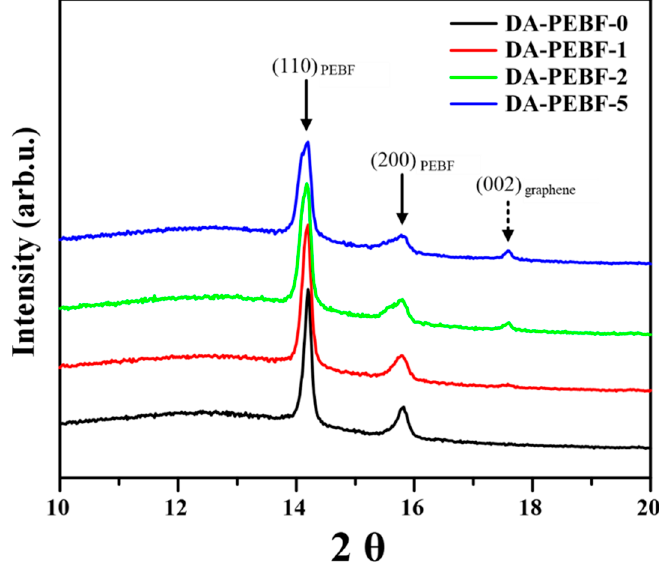
Figure 8. WAXS patterns of DA-PEBF-0, DA-PEBF-1, DA-PEBF-2, and DA-PEBF-5. The solid arrows correspond to the ( 110 ) and ( 200 ) crystallographic planes of EB segments in PEBF, and the dashed arrow indicates the ( 002 ) reflection of graphene.